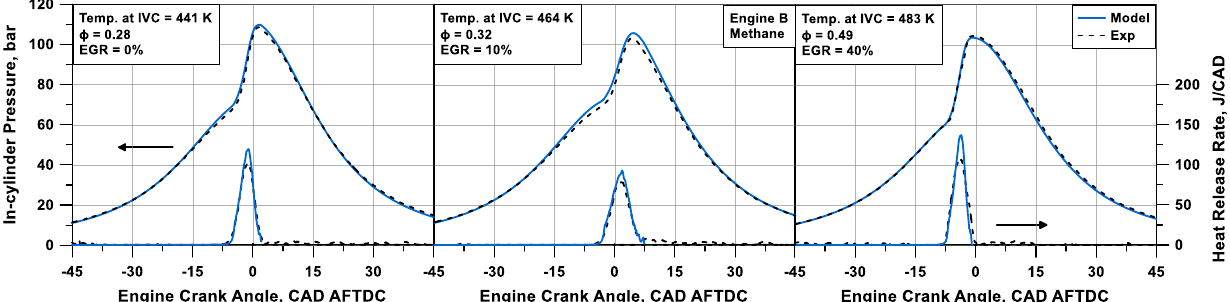
Figure 11. Numerical/experimental comparison of in-cylinder pressure traces and heat release rate profiles for Engine B.